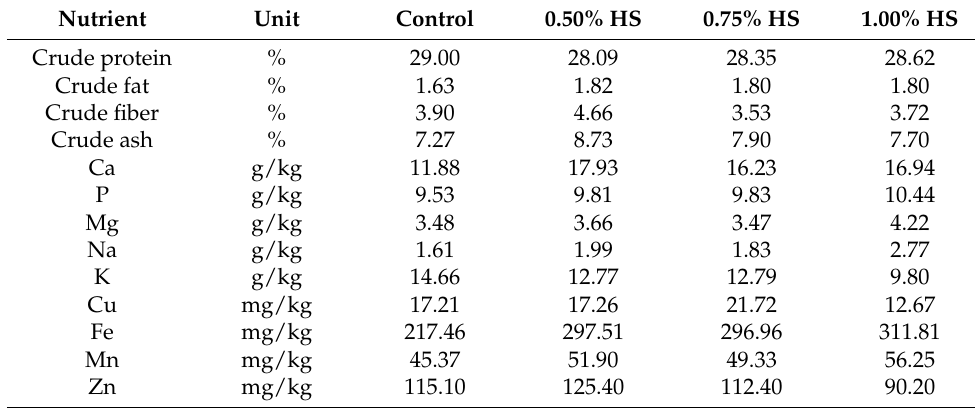
Table 1. Nutrient composition of diet: starter.